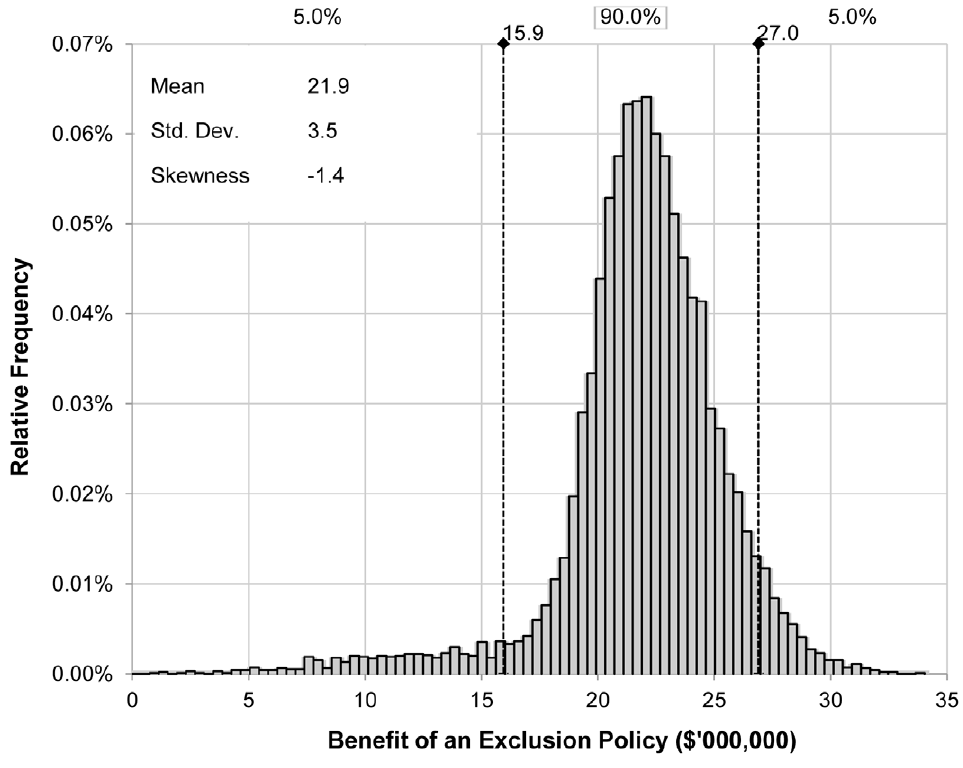
Figure 2. Expected annual benefit of a BBTV exclusion policy.